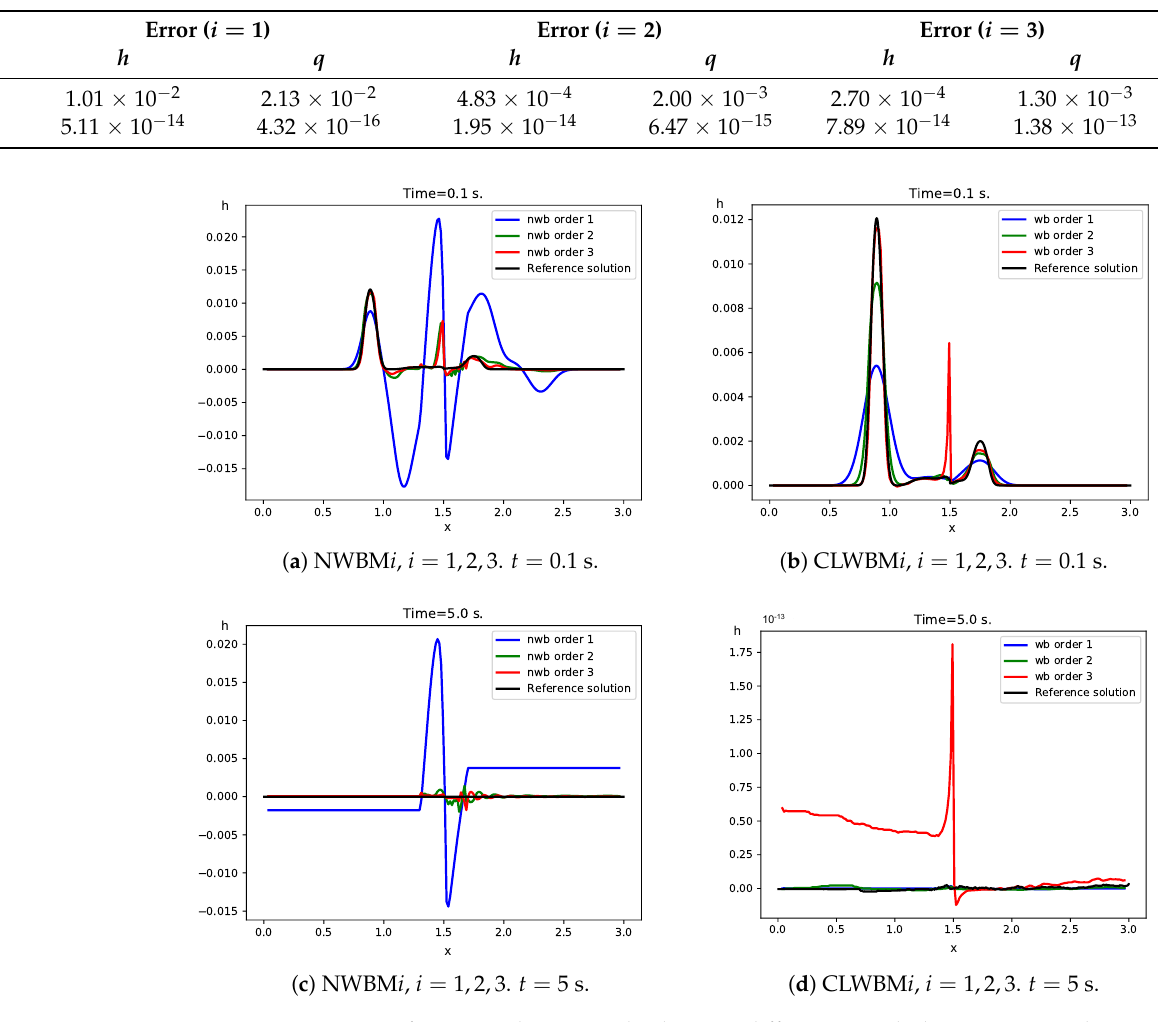
Figure 5. Test 3.2. Reference and numerical solutions: differences with the stationary solution at times t = 0.1,5 s for h with a 200-cell mesh.